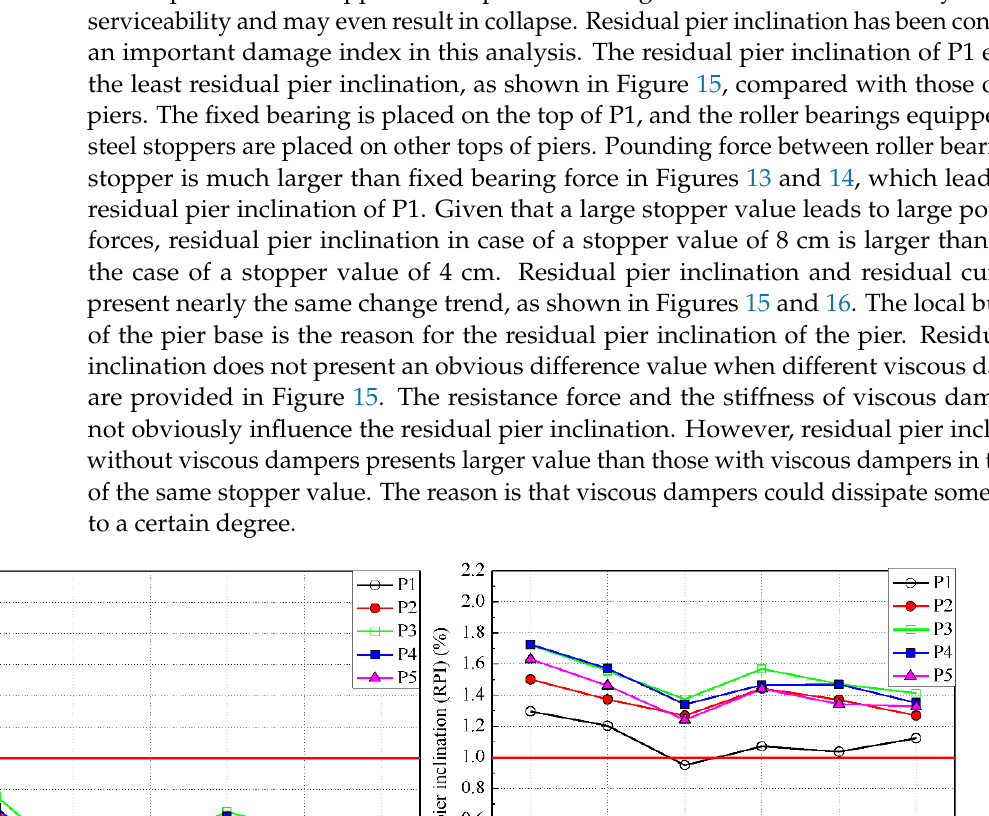
Figure 14. Maximum pounding forces between roller bearing (B4) and stopper in tangential direc- tion. ( a ) Stopper = 4 cm. ( b ) Stopper = 8 cm.